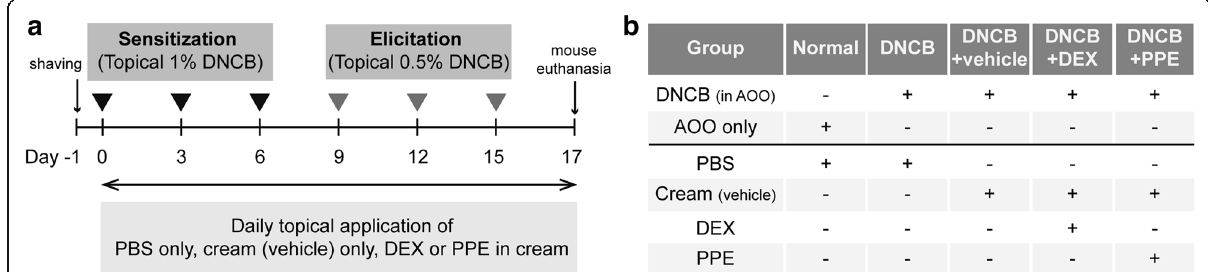
Fig. 1 Schematic diagram of the experimental design. ( a ) Induction of contact dermatitis in mice and topical PPE treatment of skin lesions. Skin inflammation was induced on the back skin of BALB/c mice by periodic topical application of DNCB-treated patches. One day prior to sensitization, mouse dorsal hairs were completely removed, and 1% DNCB-treated patches were attached to back skin for 20h on days 0, 3 and 6. Following sensitization, 0.5% DNCB patches were applied on days 9, 12, and 15 for elicitation of responses. Upon removal of DNCB patches, PPE in cream was topically applied to skin lesions every day until the end of the experiment (total of 17days). PBS or cream (vehicle) alone was applied as a negative control and DEX treatment used as a positive control. ( b ) Experimental conditions for each mouse group. Mice were divided into 5 groups representing different experimental conditions ( n =6 per group). Except for the normal group, DNCB in AOO was applied to four mouse groups